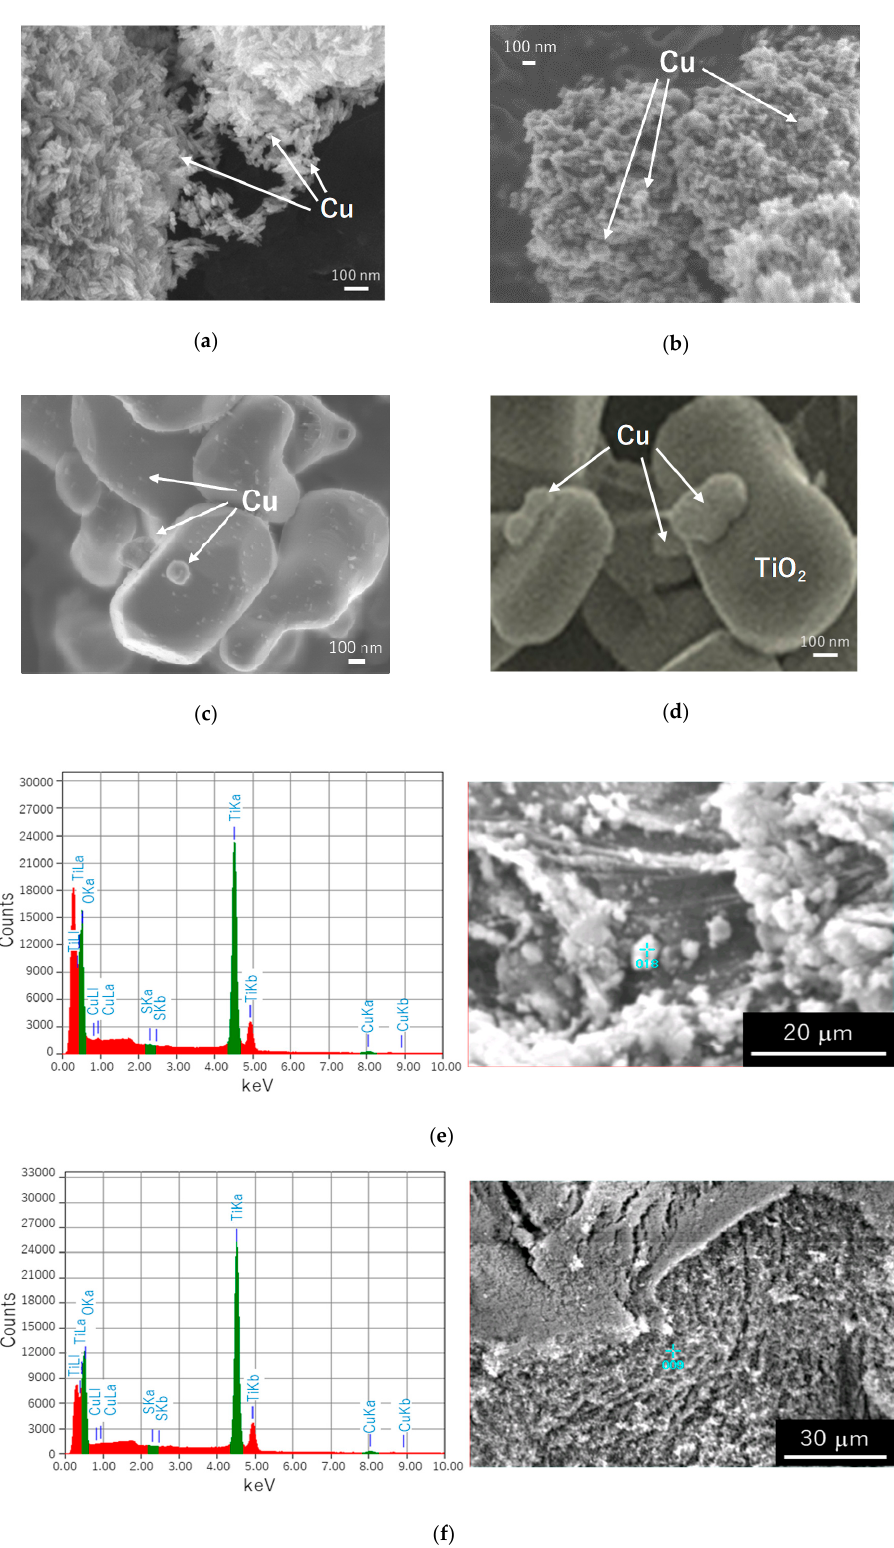
Figure 4. ( a – d ) Scanning electron microscopy (SEM) images of: ( a ) CuTIO-6m-1h, ( b ) CuTIO-6m-5h, ( c ) CuTIO-5m-1h and ( d ) CuTIO-5m-5h. ( e , f ) Energy-dispersive X-ray spectroscopy (EDS) and corresponding SEM images of ( e ) CuST-01m-5h and ( f ) CuST-41m-5h.